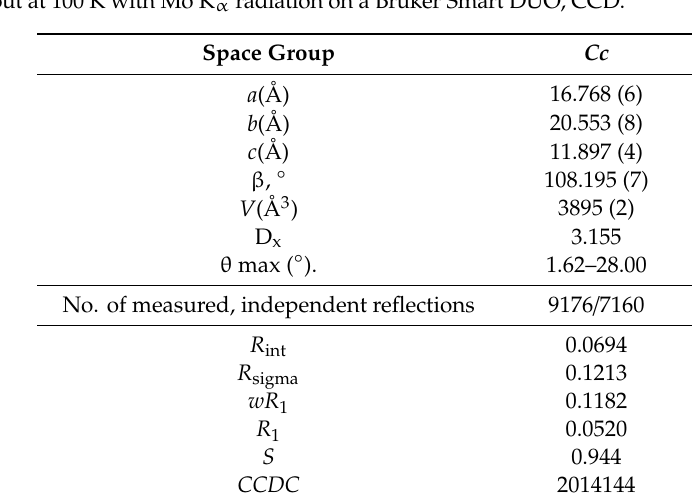
Table 1. Crystallographic data and refinement parameters for [C 3 H 9 NH + ] 4 [(UO 2 ) 3 (MoO 4 ) 5 ]. Experiments were carried out at 100 K with Mo K α radiation on a Bruker Smart DUO, CCD.